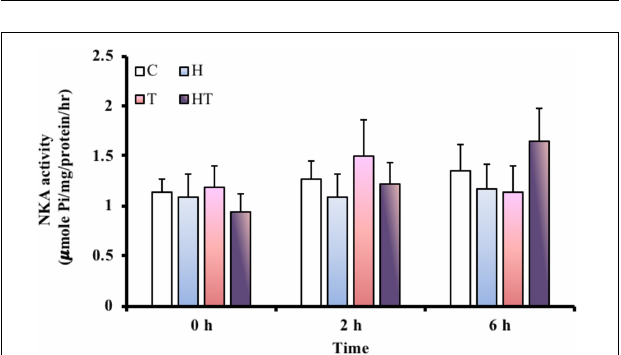
FIGURE 6 | NKA activity in gills of M. opercularis in control (C), hypoxic (H), thermal (T), and hypoxic-and-thermal (HT) treatment groups at 0, 2, and 6 h ( n = 7–9). There were no statistically significant differences among treatments and times. Data are presented as mean ±